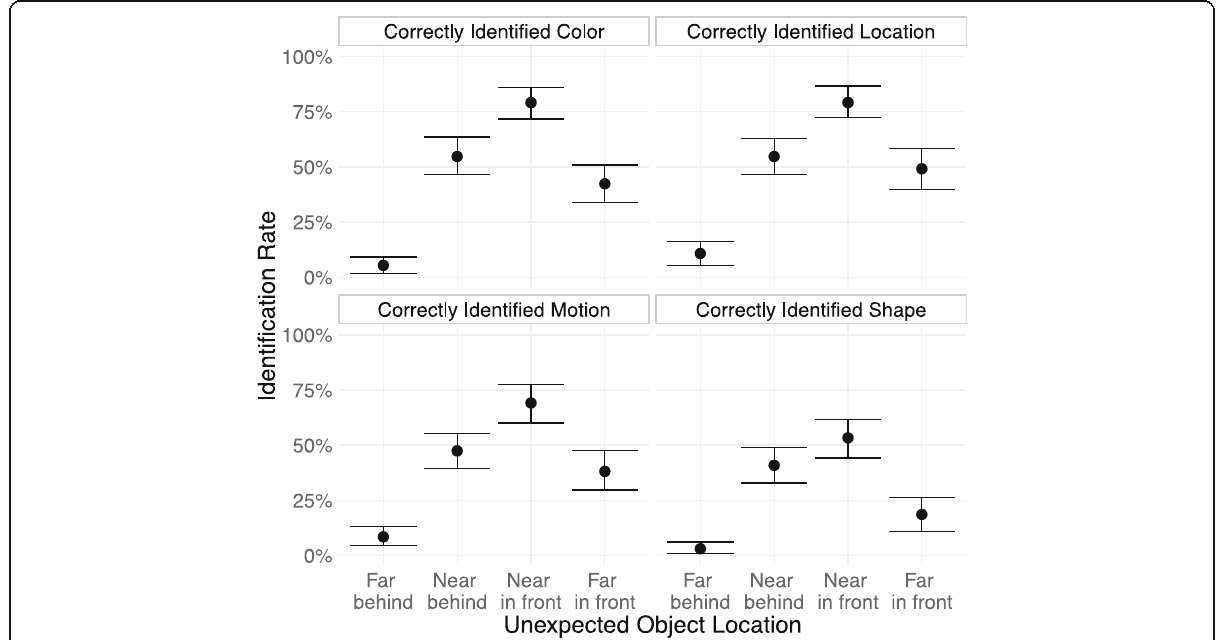
Fig. 2 Rate at which subjects who reported seeing a new object successfully identified the unexpected object ’ s features, broken down by each possible object position. Error bars are 95% bootstrapped confidence intervals. To be counted as correctly identifying a feature of the unexpected object, subjects first had to report noticing something new, and: for color, report that the new object was green; for location, report which side of the screen the object was on; for motion, report that the object was not moving; and for shape, report that it was a